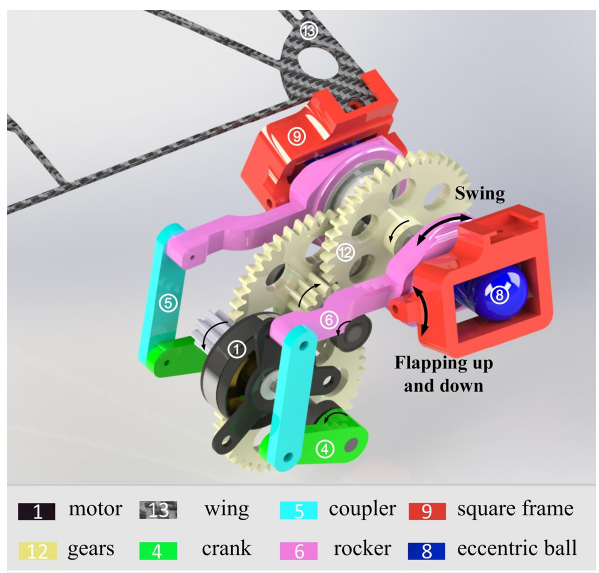
Figure 2. A 3D model of the flapping mechanism of